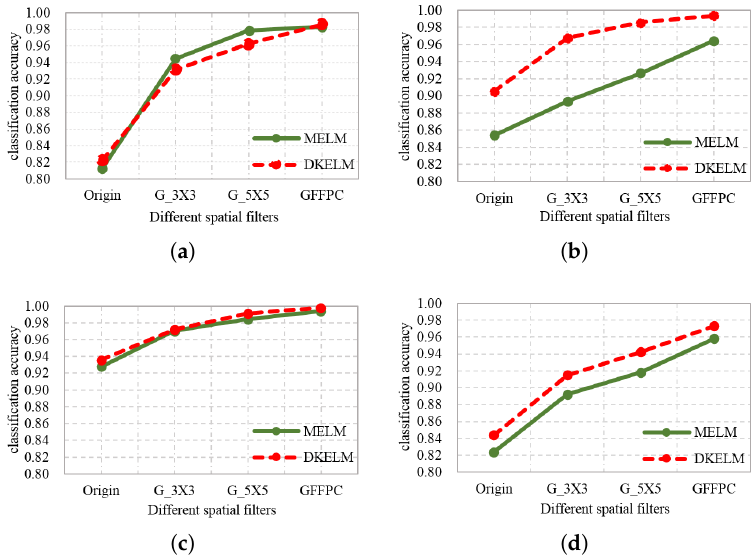
Figure 13. The performance of different spatial filters combined with MELM and DKELM in ( a ) Indian pines, ( b ) University of Pavia, ( c ) Salinas, and ( d ) Glycine ussuriensis